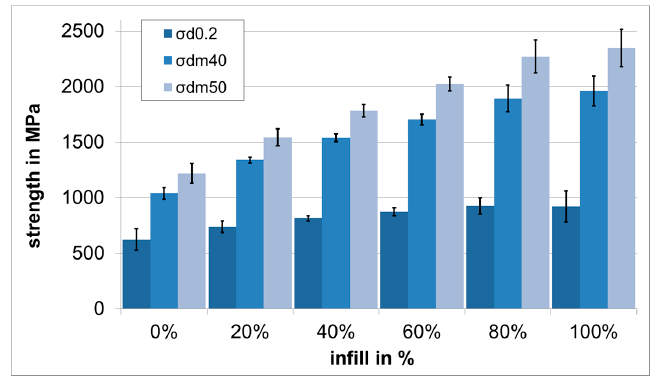
Table 5. Density of turned cylinders with 100% infill ( n = 3).